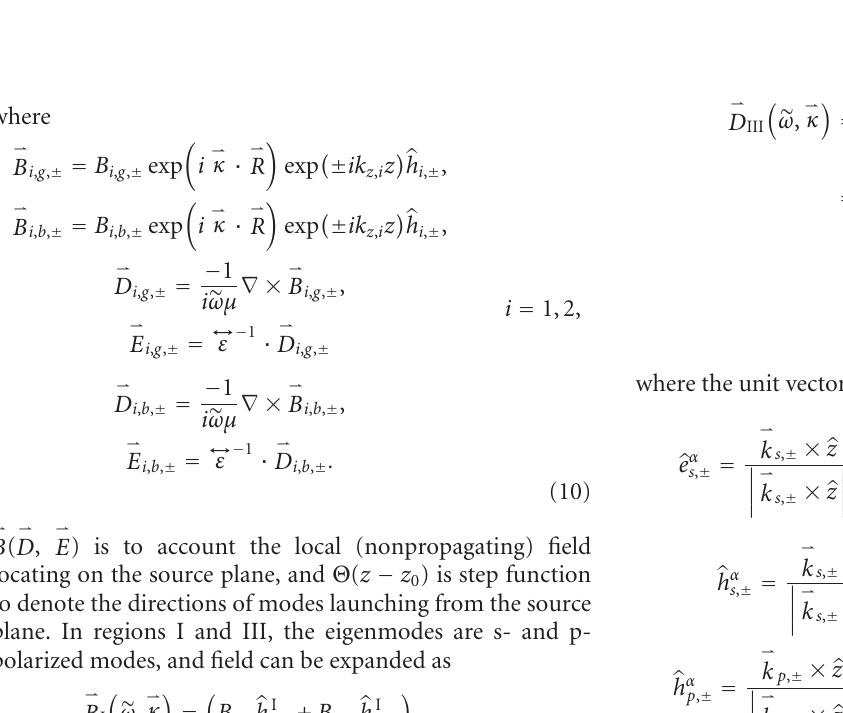
Figure 2: Schematic illustration of eigenmode expansion in three regions: the minus sign is to denote the direction of propagating is along z − direction; (cid:2) the source plane, B 2, g , ± is to denote the second eigenmode generated from the source plane, bouncing back at the upper and lower boundaries, and (the plus and minus signs denotes the propagating along z + and z − directions); III, and the minus sign is to denote the direction of propagating is along z +